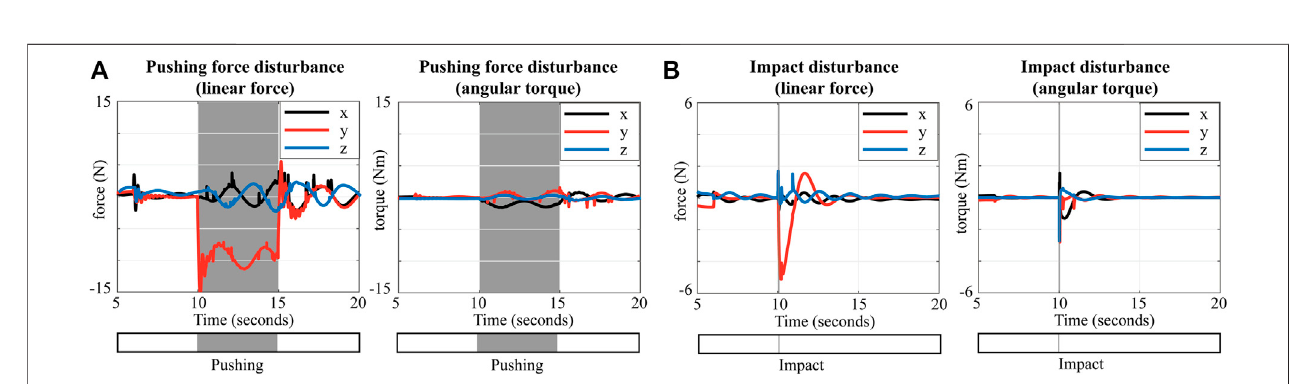
Frontiers in Robotics and AI |